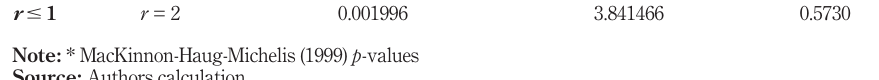
Table 6. Results of Johansen cointegration test (maximum Eigen